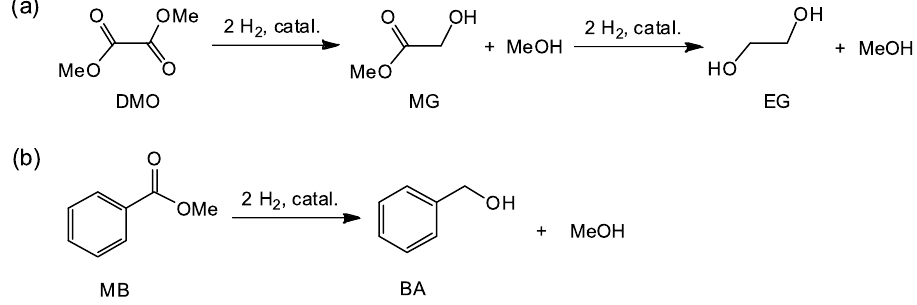
Figure 1. ( a ) Catalytic hydrogenation of DMO into MG (or EG). ( b ) Catalytic hydrogenation of MB into BA.